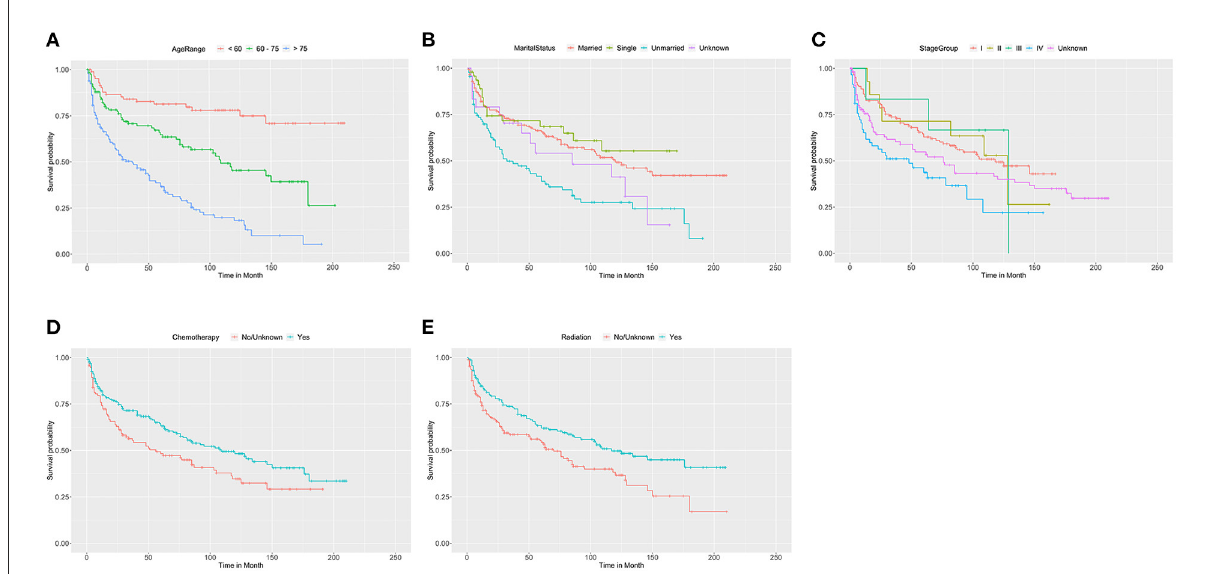
FIGURE2 The Kaplan-Meier survival curve of OS in patients with orbital DLBCL stratifed by (A) age at diagnosis, (B) marital status, (C) stage, (D) chemotherapy, and (E) radiation. It was revealed that older age, unmarried status and stage IV were associated with worse OS compared by log-rank test. In (A) , 60-75 vs < 60 years ( p < 0.001); > 75 vs. < 60 years ( p < 0.001). In (B) , Unmarried vs. Married ( p < 0.001); Single vs. Married ( p = 0.520); Unknown vs. Married ( p = 0.221). In (C) , stage IV vs. stage I ( p = 0.001); stage II vs. stage I ( p = 0.919); and stage III vs. stage I ( p = 0.853), and unknown vs. stage I ( p = 0.089). In (D,E) , chemotherapy ( p = 0.016) and radiation therapy ( p = 0.004) had significantly better OS than those without it.